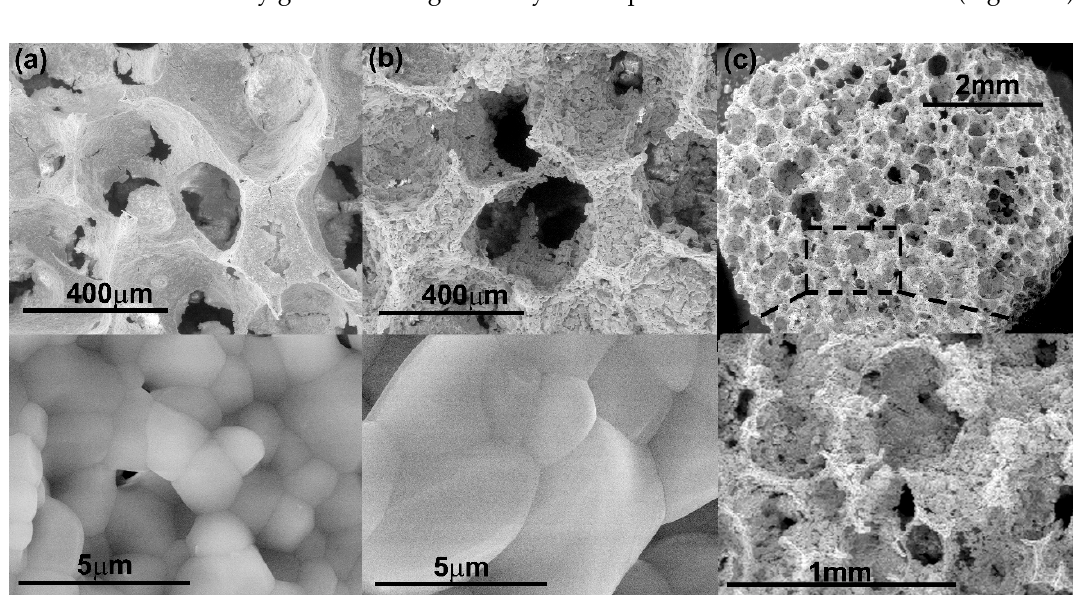
Figure 6. Micrographs of the structure of scaffolds with 40 wt.% of solid content and fabricated at ◦ C. ( a ) HA; ( b ) and ( c ) β 1200 °C. a ) HA; b ) and c ) β‐ TCP. 1200